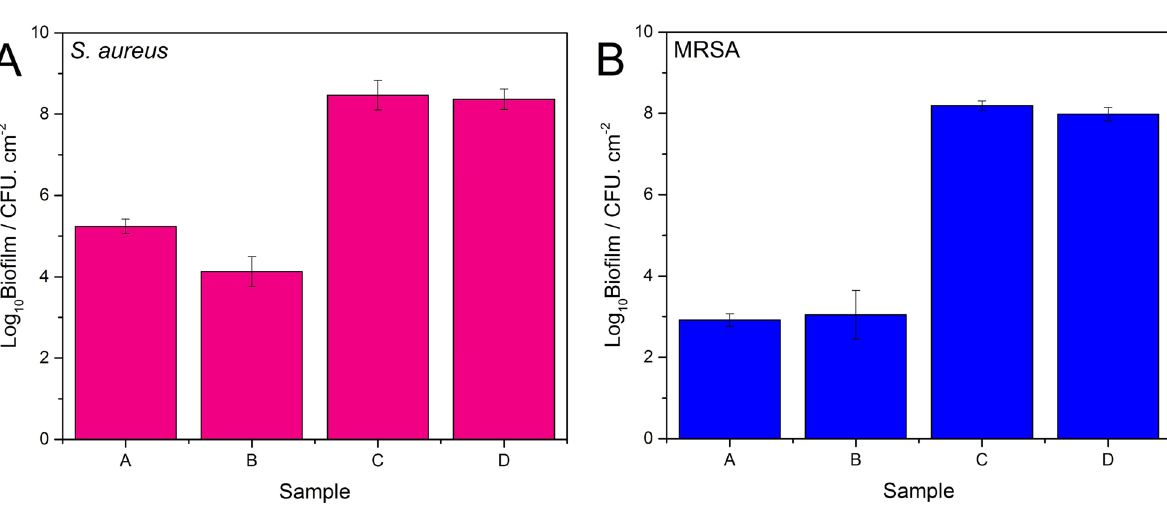
Figure 7. Viability of S. aureus (Panel A ) and MRSA (Panel B ) biofilm cells in the presence of glass slides. Sample ( A ): PEM with nisin Z outer layer; Sample ( B ): PEM with nisin Z/CAR outer layer; Sample ( C ): PEM without nisin Z and; Sample ( D ): Blank glass slide. The data are a minimum of two biological replicates. Note: the biofilm cells were formed in situ from the planktonic cells during the course of the 6.5 h incubation. The data are from a minimum of two biology experiments, with two replicates in each (i.e. at least 4 measurements in each